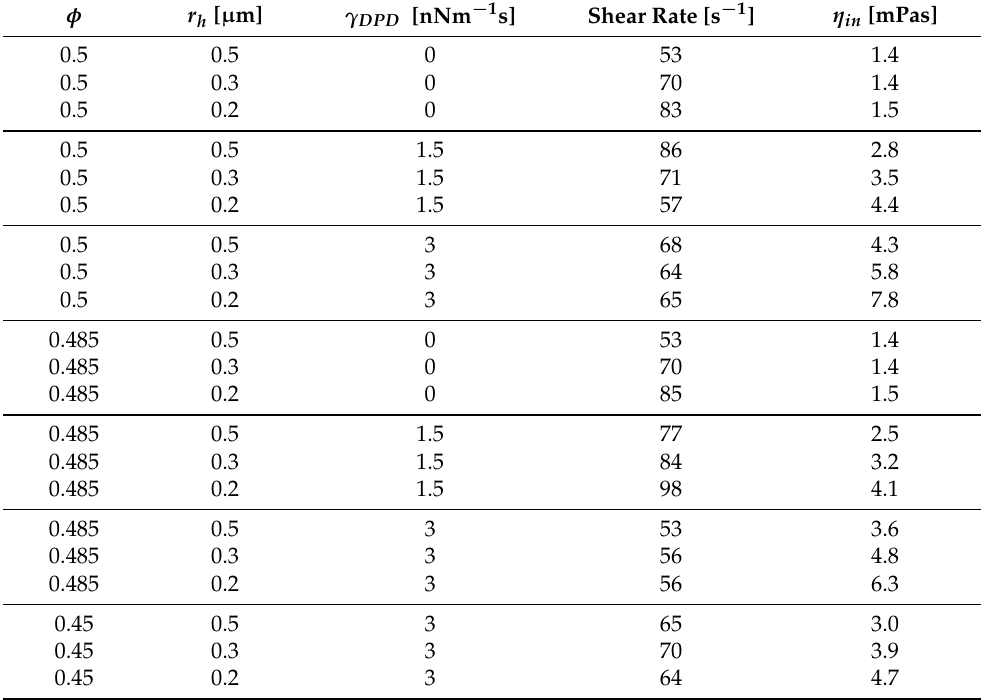
Table A5. Effective viscosity of particle suspensions in shear flow between parallel plates. The vis- cosity of the underlying fluid was 1.2 mPas. For γ DPD = 0 we used the soft-sphere interaction.